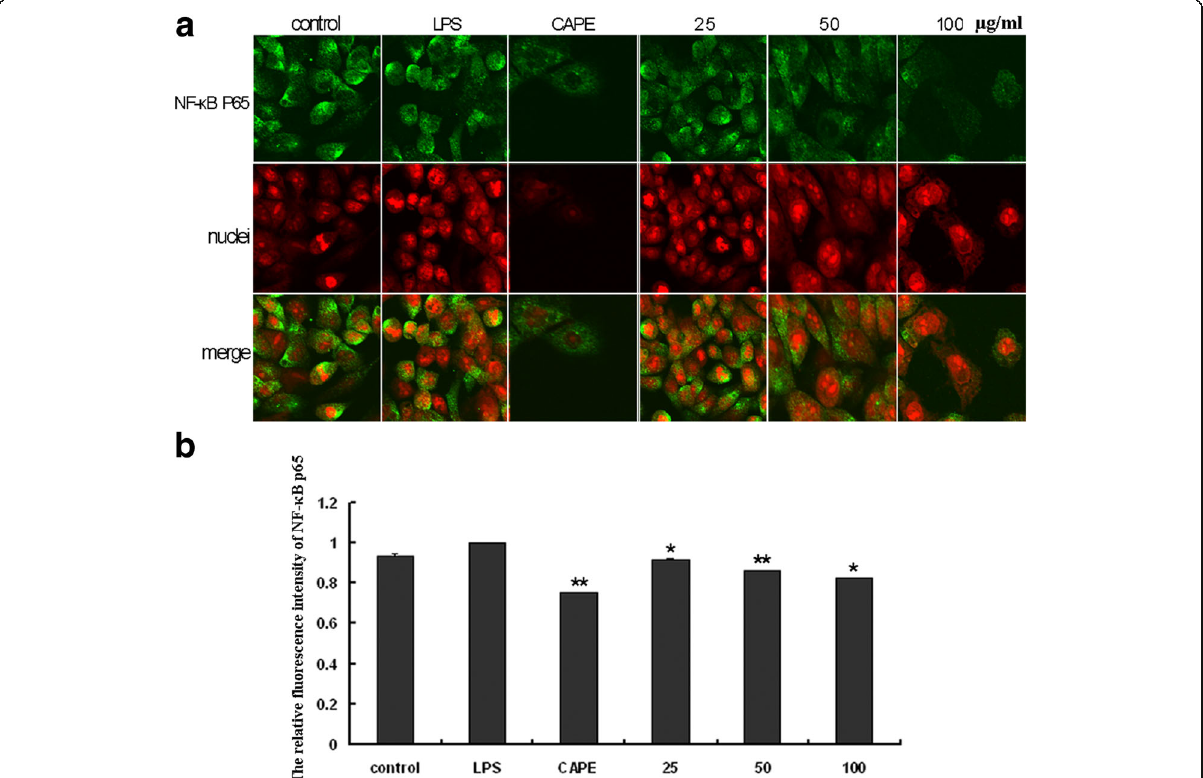
Fig. 7 EECP and CAPE regulated the levels of NF- κ B p65. a Fluorescent micrographs obtained at 48 h (×400). b The relative fluorescence intensity of NF- κ B p65 in LPS-stimulated MDA-MB-231 cells. ( * P < 0.05, ** P < 0.01 vs control, n = 3). Data are means ±